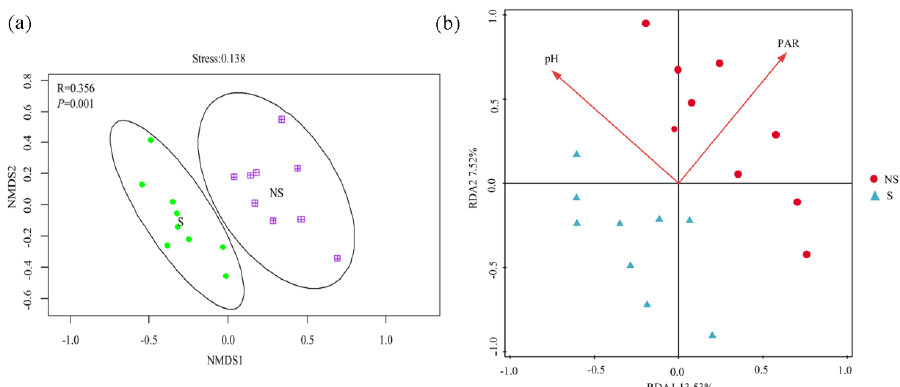
Figure 7. Beta diversity of fungal communities based on Bray–Curtis distance (on OTU level) ana- lyzed by NMDS plots ( a ) and redundancy analysis of the correlation between environmental fac- tors and fungal community structure ( b ). After removing non-protist eukaryotes, the samples were subsampled based on the minimum sequence number of samples. Consequently, 64,278 sequences were binned into 1,112 OTUs using the 97% sequence identity criterion. The compositions of the pro- tistan communities were described according to the relative abundances at the phylum level. Cercozoa (38.57%) and Ciliophora (27.27%) were the most dominant phyla (Figure